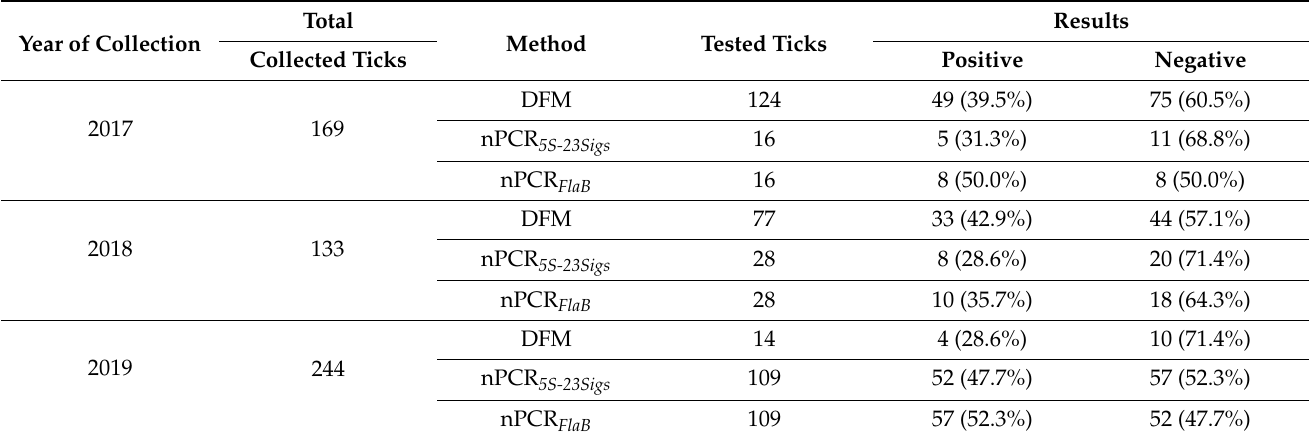
Table 4. Results from testing by DFM, nPCR 5S-23Sigs , and nPCR FlaB for Borrelia infection in I. ricinus during the collecting campaign